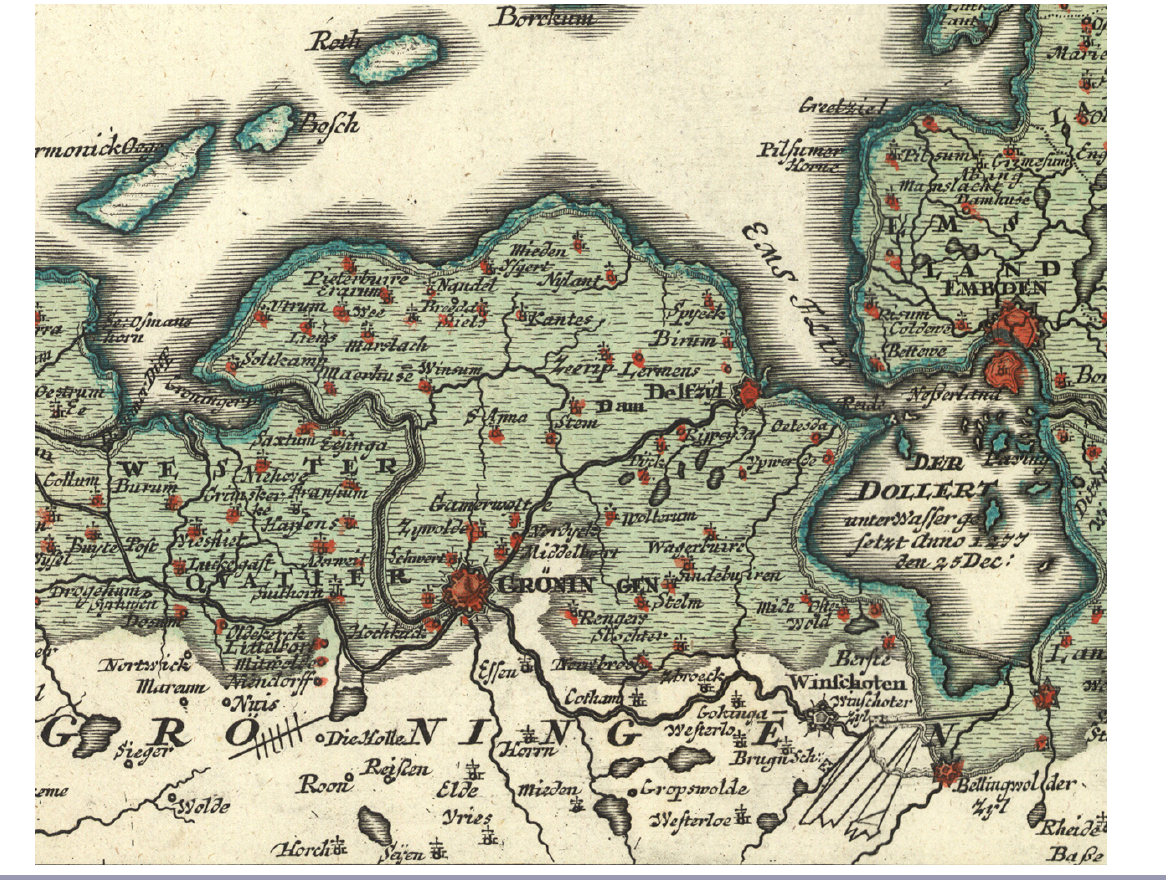
Fig. 5 . Detail from Geographische Vorstellung der jämerlichen Wasser-Flutt in Nieder-Teutschland, edit